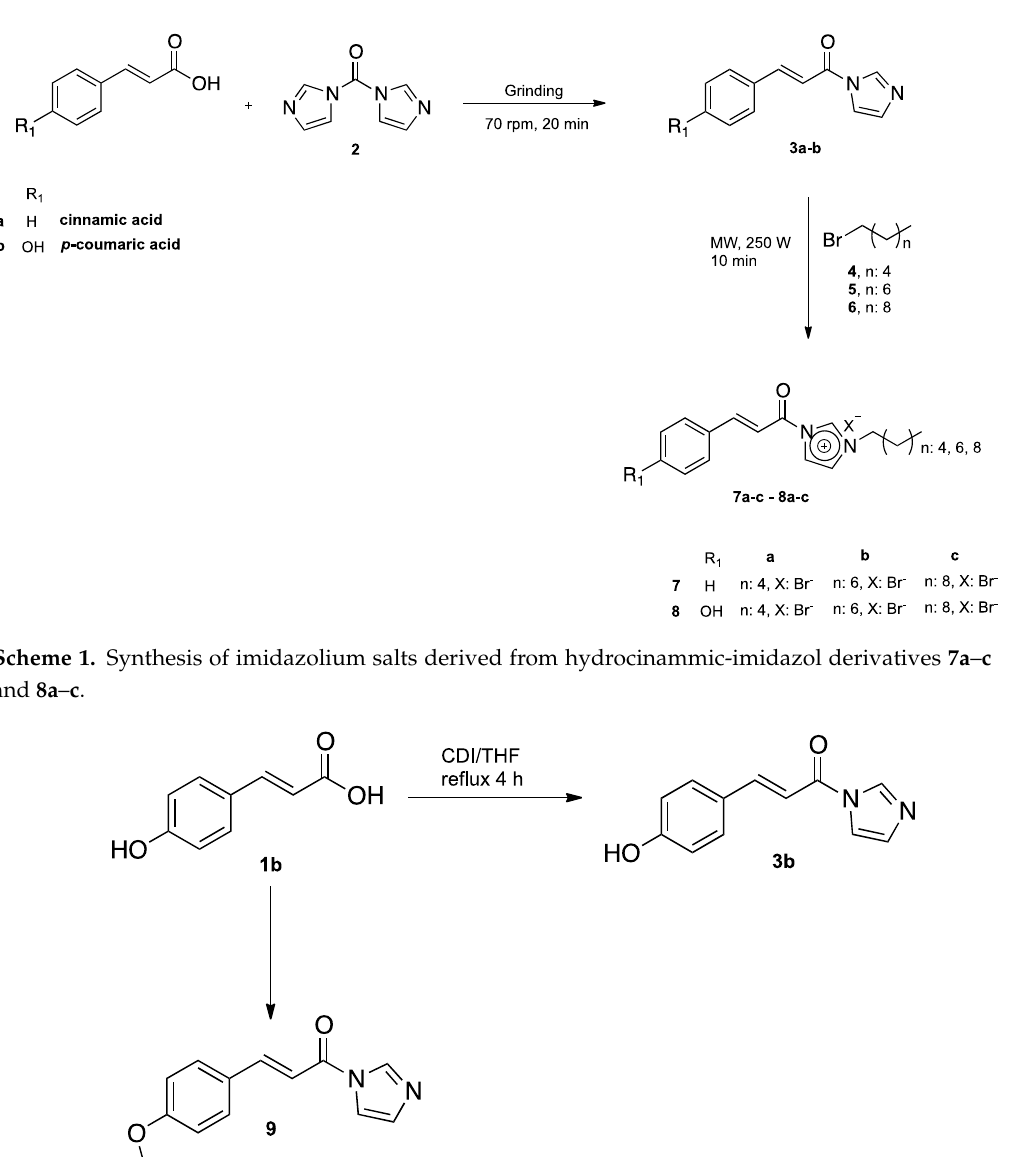
Figure 1. Minimum inhibitory concentration (MIC) determination by microdilution in a 96-well plate. The line indicates the last dilution where bacterial viability was not evidenced. Columns (1–12): different N -alkylimidazolium salts (in duplicate). Rows (A–H): seriated dilutions of each salt (2 - 0.015626 mM) None of the precursors studied ( 3a and 3b ), at the concentrations used, showed antibacterial activity (Table 1). In Gram-positive bacteria ( S. aureus and S. epidermidis ), the salts derived from cinnamic acid showed a correlation between the antibacterial activity and the length of the alkyl chain, with a lower MIC being obtained as the alkyl chain increased. By adding a hydroxyl group to the molecule (coumaric acid), an improvement in the antibacterial activity was seen in the salts that had an alkyl chain of 8 and 10 carbons (four and two times, respectively) in comparison with those that did not possess the modification and had the same length of the chain; however, no difference in the antibacterial activity was seen when the alkyl chain had six carbons. In Gram-negative bacteria, minimal antibacterial activity was observed against P. aeruginosa , with an MIC value of over 2 mM in both cases. In the case of the antibacterial activity against Acinetobacter baumannii , the same MIC was observed in the salts with six carbons; nevertheless, a better effect was observed in the salts with a chain length of 8 and 10 carbons without a hydroxyl group, contrary to what was observed in Gram-positive bacteria.